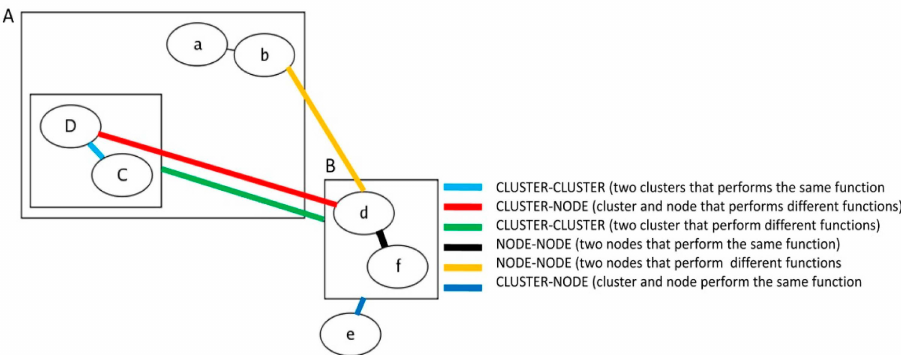
Figure 5. Graph Model defined by Node, Edge and Cluster